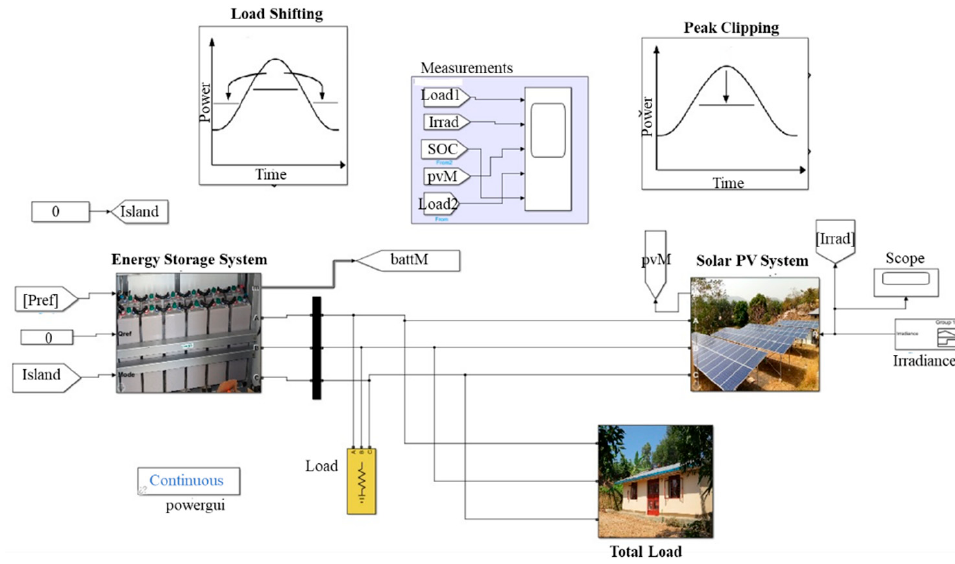
Figure 2. Microgrid Simulink model of the case study (image sources [48]). The total load was divided into deferrable and non-deferrable load to enhance switch- ing on/off loads during peak and off-peak hours. Figure 3 represents the simulation of the two categories of load in